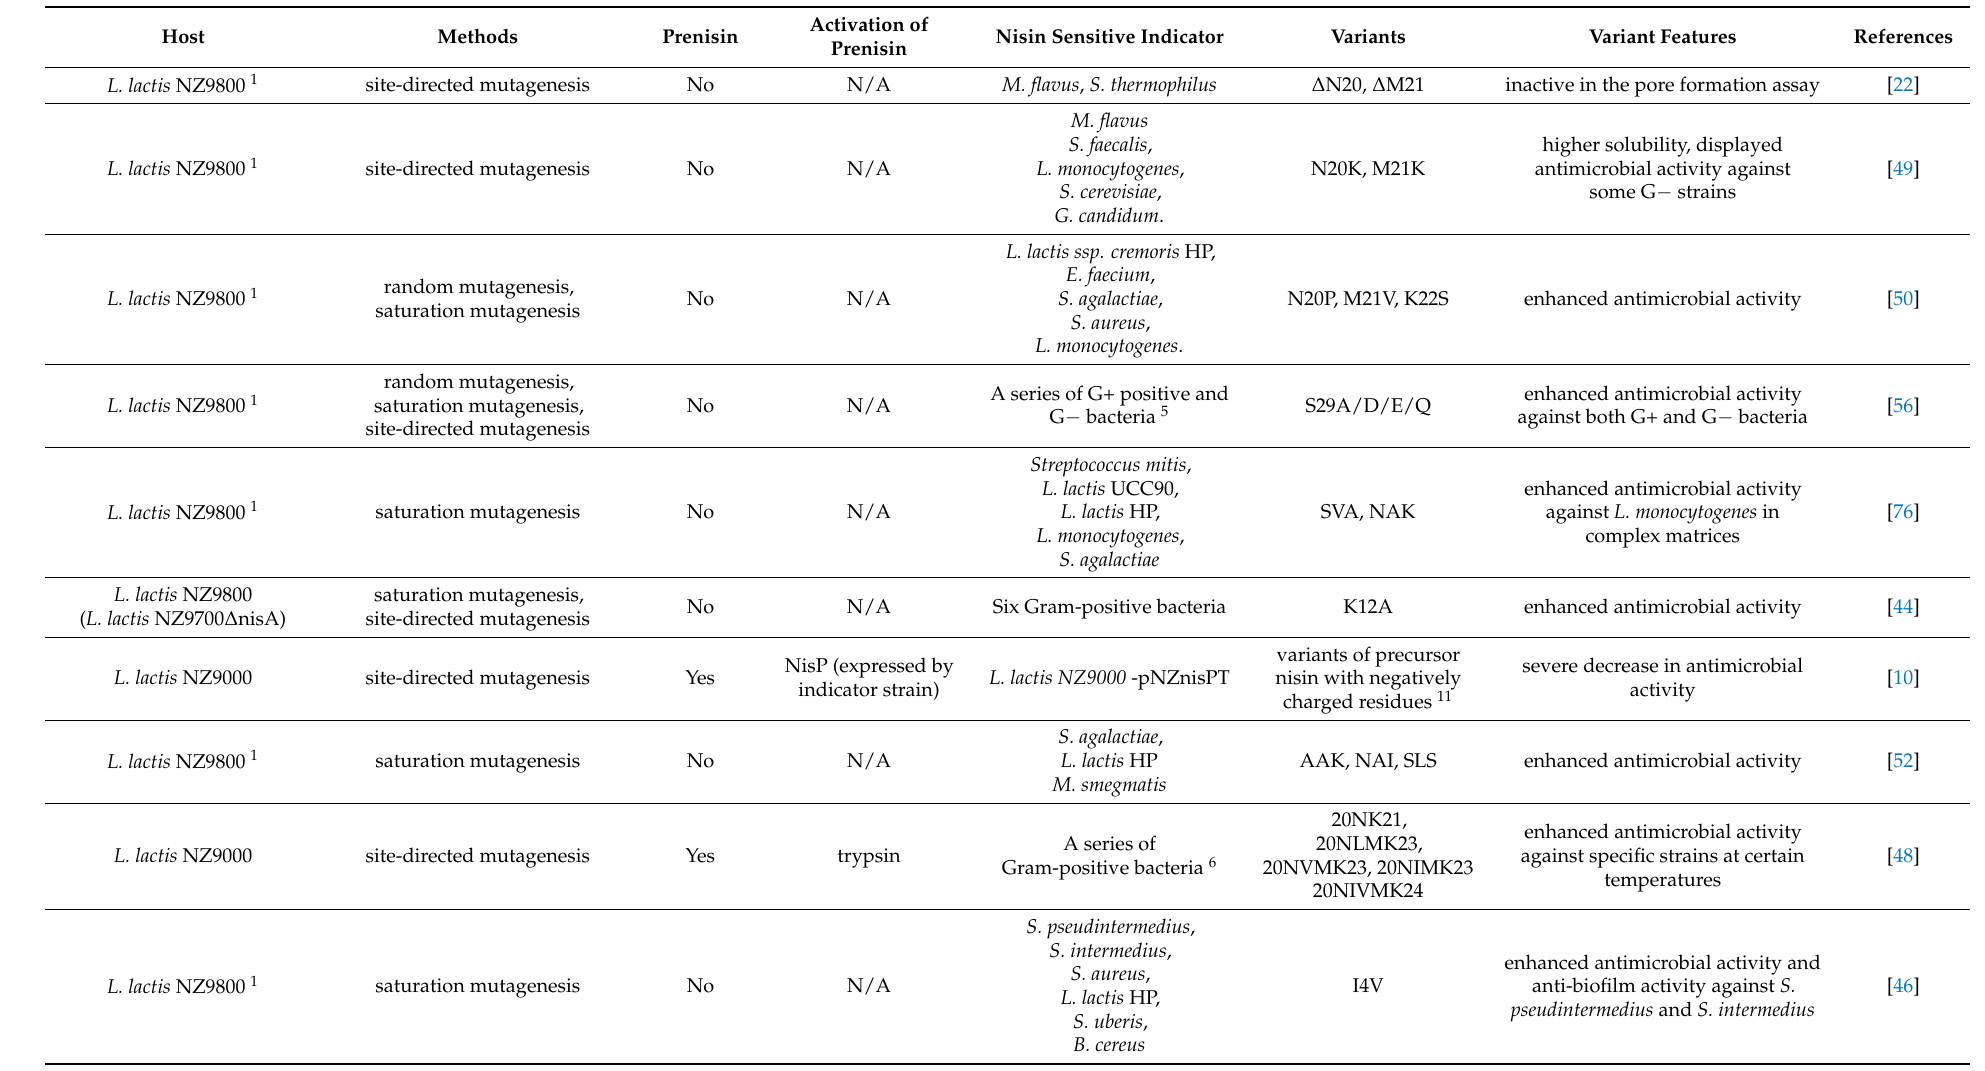
Table 1. Nisin variants produced by bioengineering in different